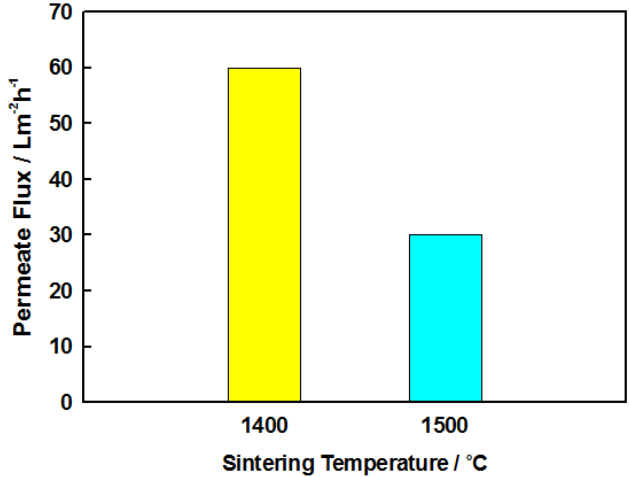
Figure 5. The membrane distillation (MD) permeate flux of as-prepared hydrophobic hollow fiber sintered at different temperatures in vacuum membrane distillation (VMD).